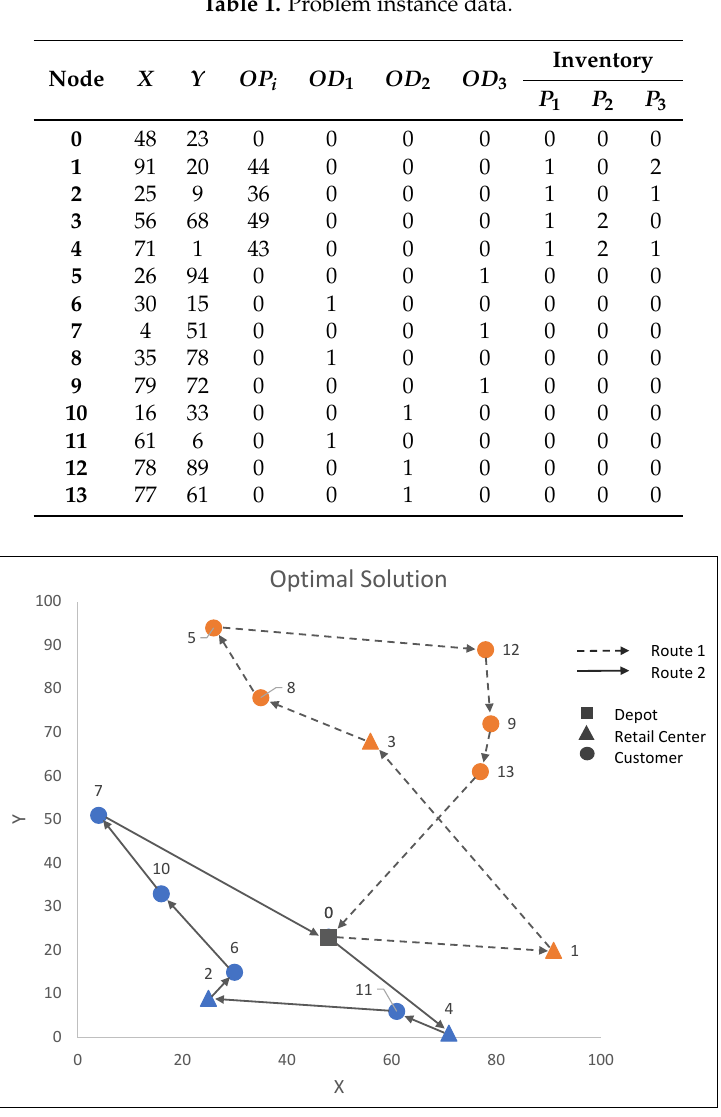
Figure 2. The optimal solution routes for Table